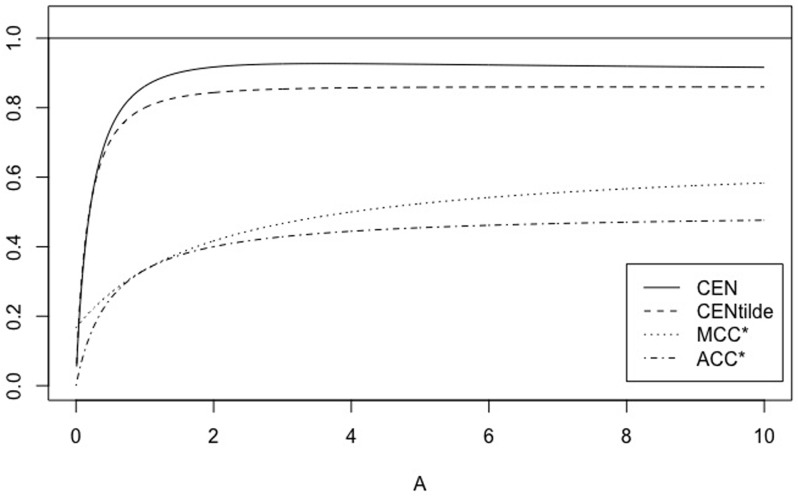
Family XA, r.CEN, MCEN, ACC* and MCC* as function of A > 0 for r = 0.5.